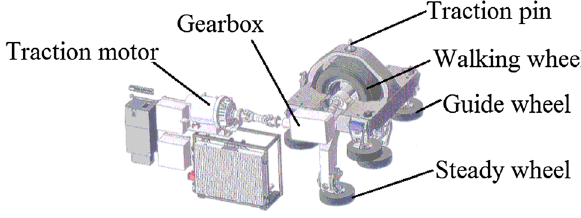
with the axle. Axle boxes are designed outside of the walking wheel axle, to convert the rotation of walking wheel into translation. Tumbler structure is utilized in the axle box body. One end of the tumbler is fixed to the lower part of the framework via rotational joints, while the other end supports the framework via air springs. Holes are open